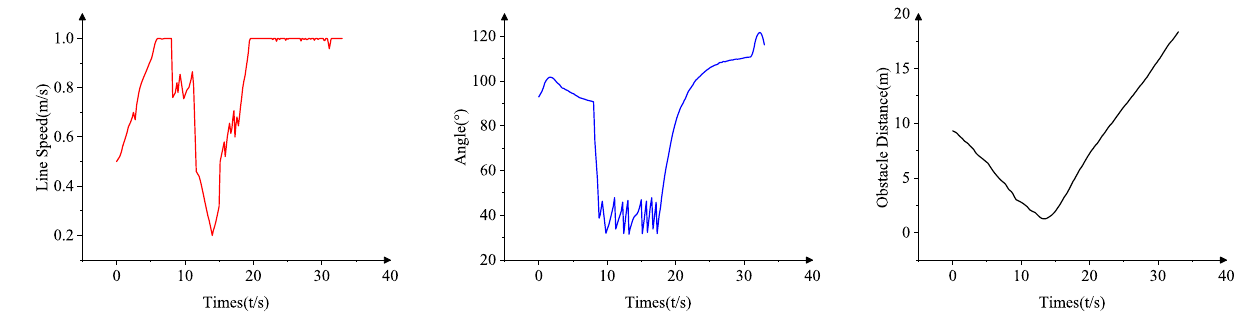
Figure 27. Parameters of the FUZZY-CCDWA algorithm for crossing situation.